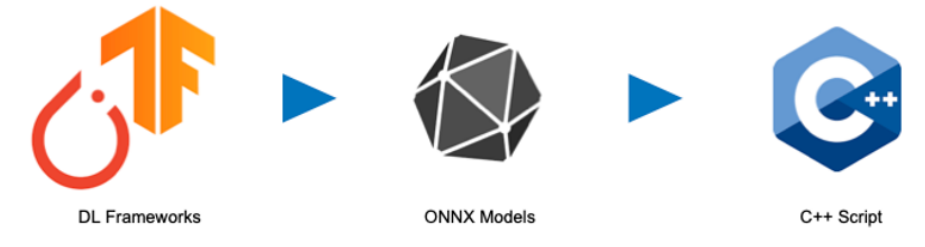
Fig. 7. Proposed work process for deploying deep learning models in C++ analysis frameworks with